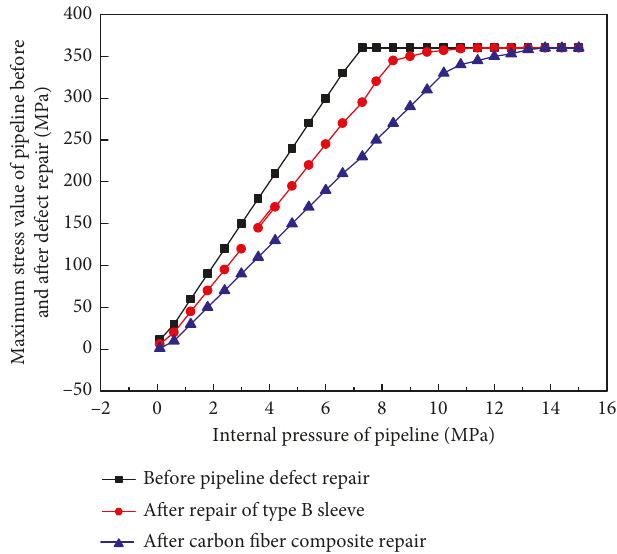
Figure 13: Composite repair stress diagram.